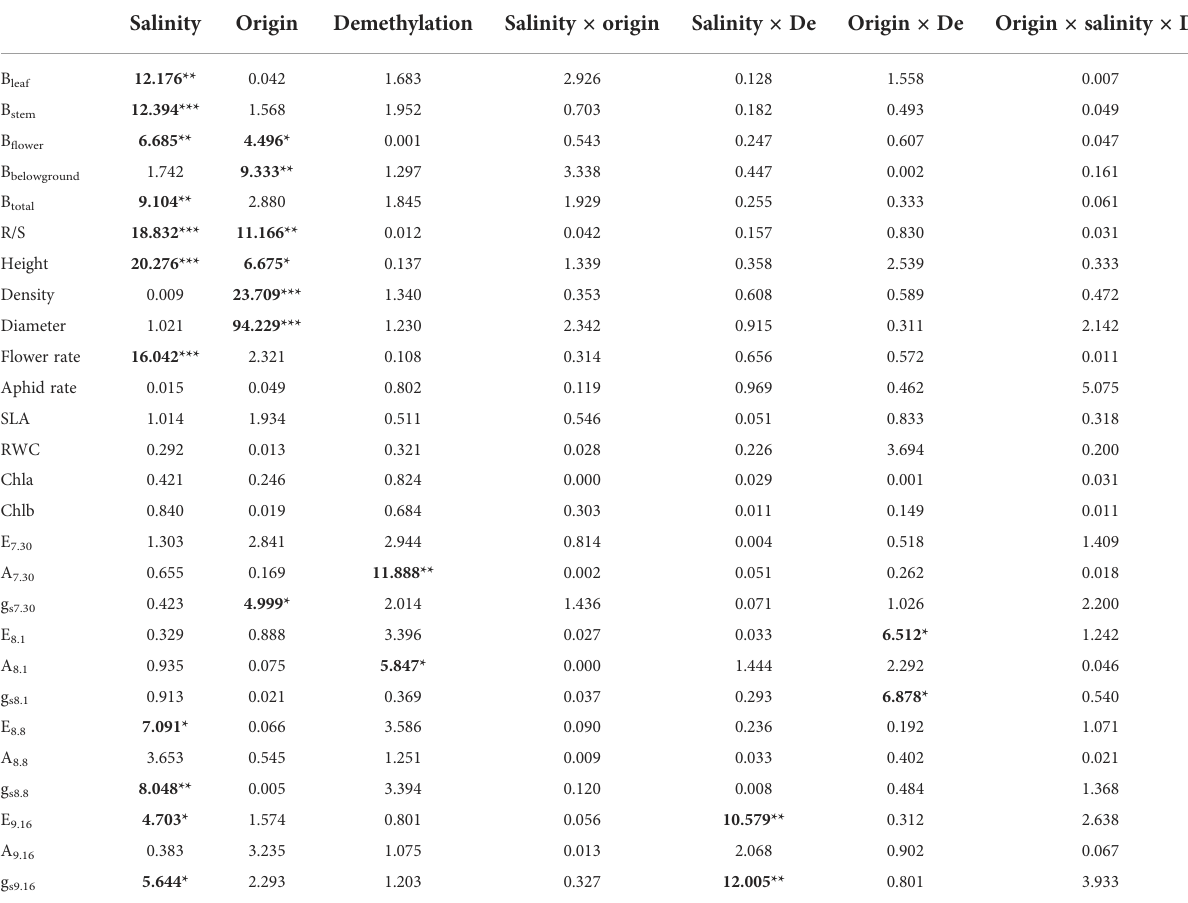
TABLE 1 Three-factor analysis of variance for phenotypic variance of different Phragmites australis origins with salinity and demethylation treatments.